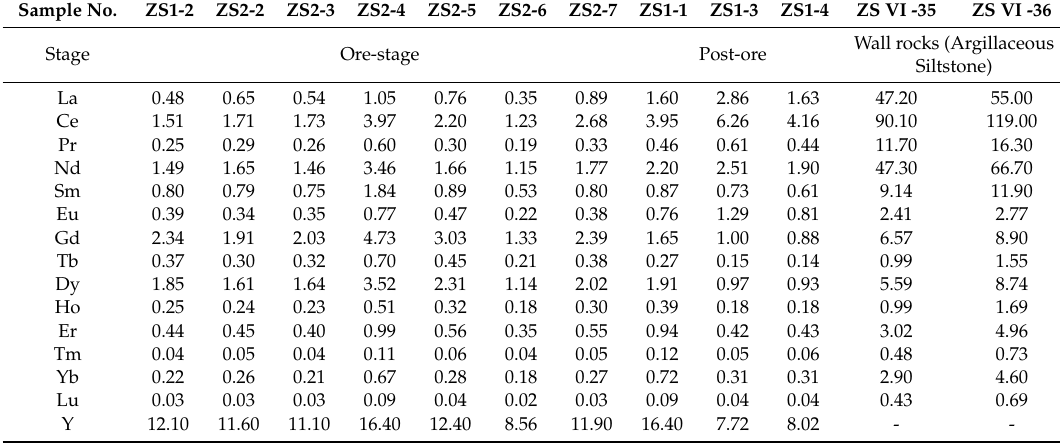
Table 2. REE data ( µ g / g) of calcites and wall rocks from the Zhesang gold deposit. Sample